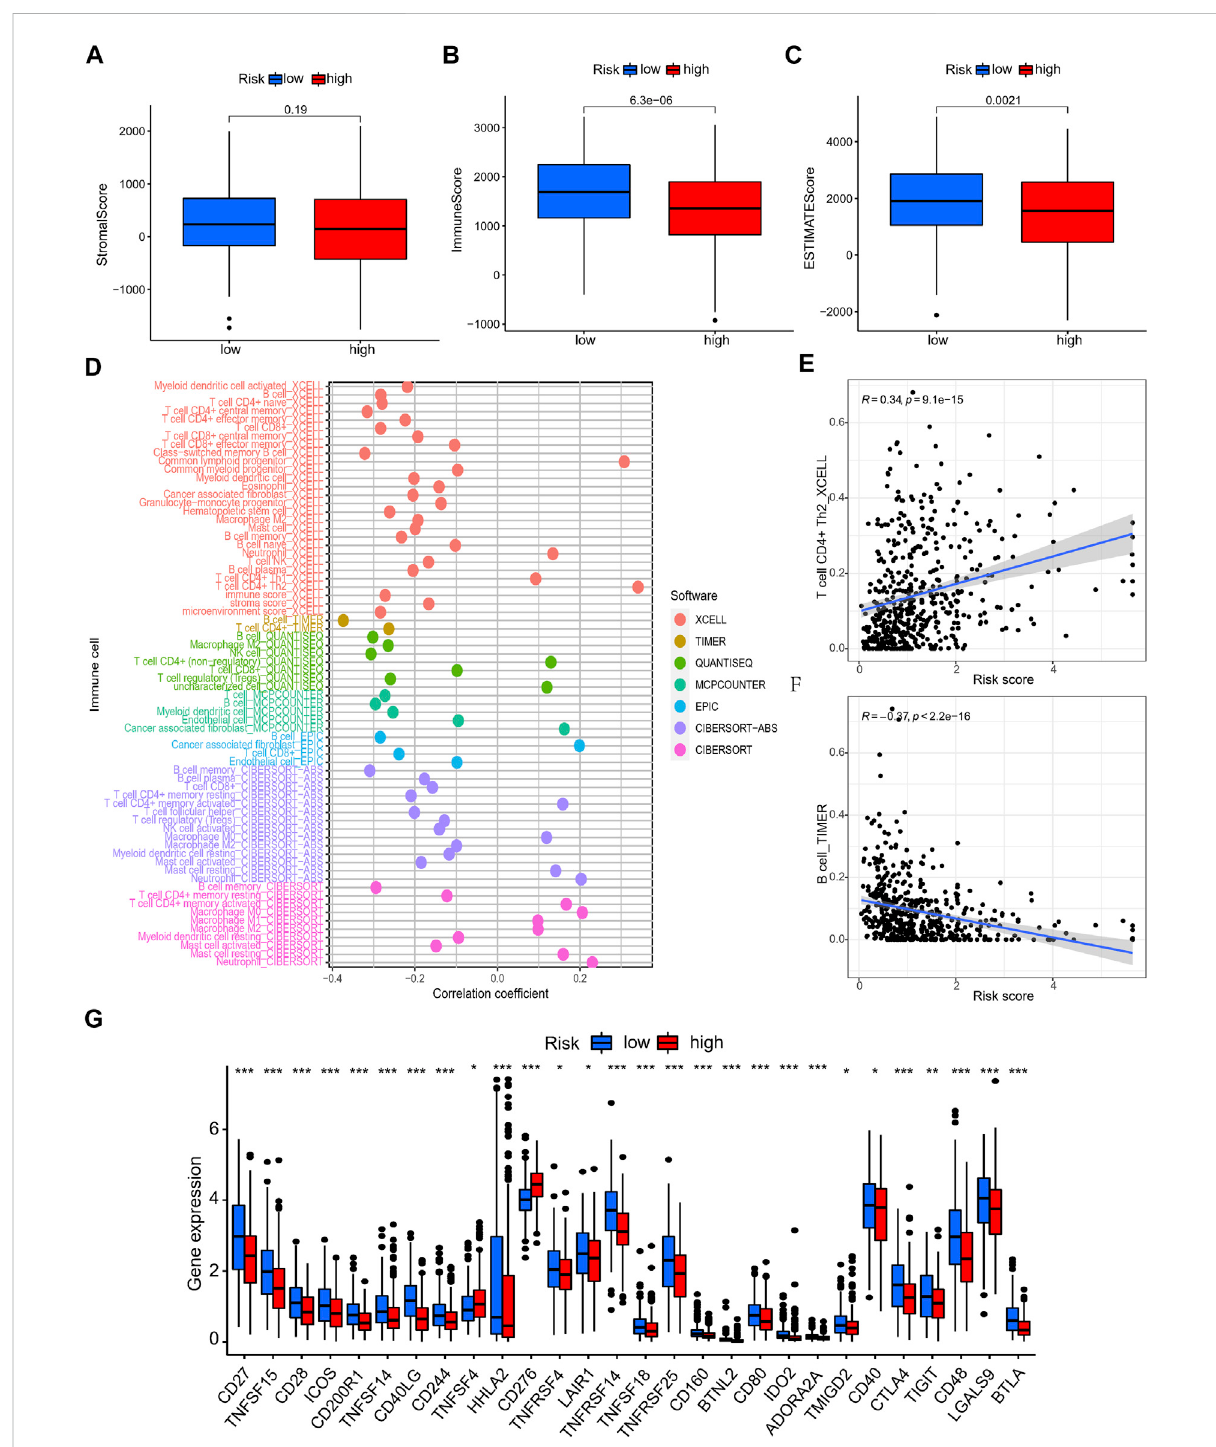
FIGURE 8 The immune landscape analysis of NRlncRNAs signature in LUAD patients. (A – C) The TME score (immune score, stromal score, and ESTIMATE score) between different risk group. (D – F) Relationship between the NRlncRNAs risk score and immune cells in fi ltration. (G) The differential expression of immune checkpoint between high- and low-risk